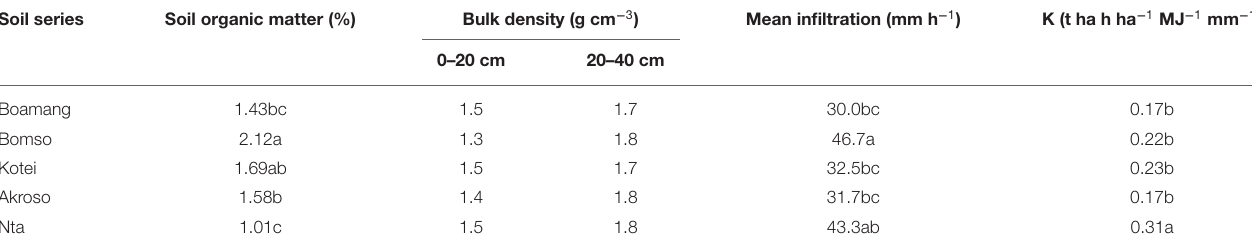
TABLE 5 | Erosion related properties of soils of the study site. Soil series Soil organic matter